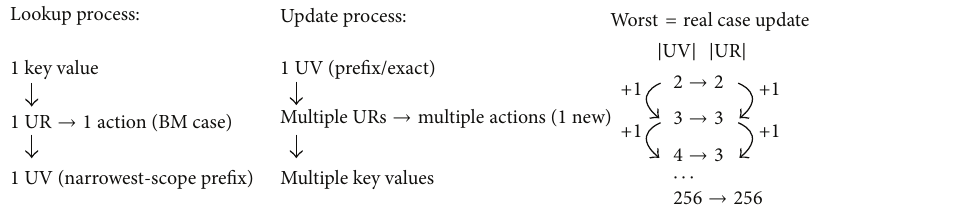
Figure 5: Best-match (BM)